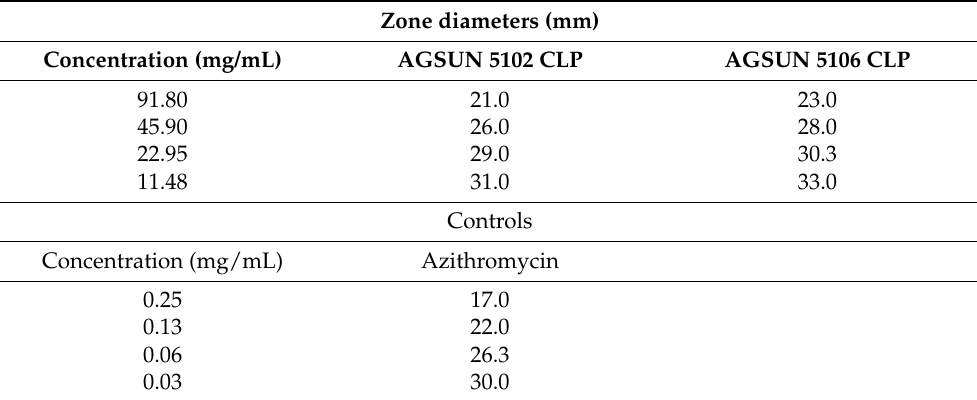
Table 4. Inhibitory effect of essential oils on QS-mediated virulence factor swimming motility of P. aeruginosa ATCC 27853 at sub-MIC concentrations